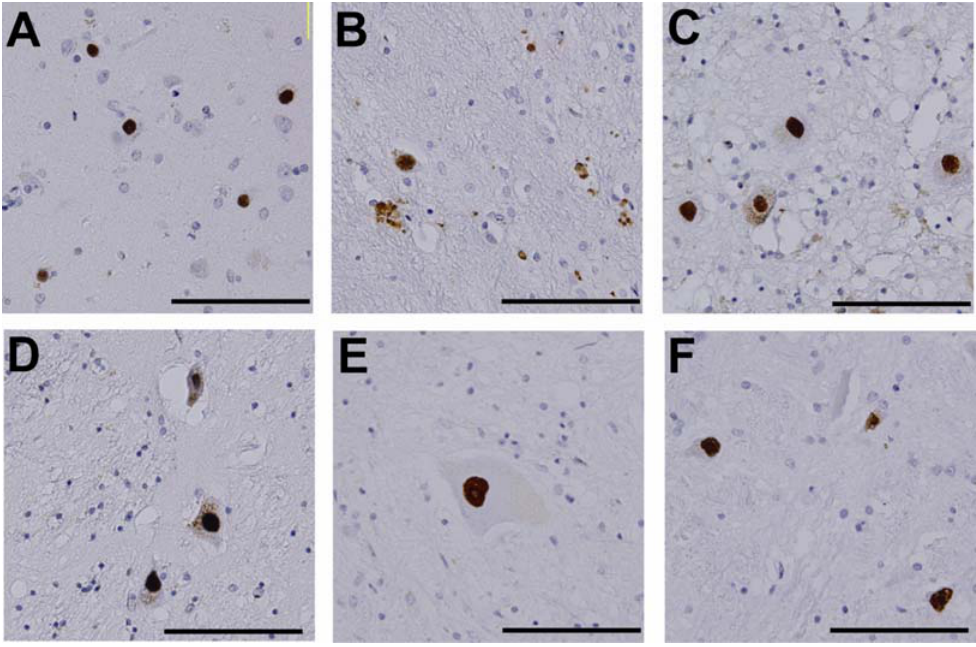
Figure 1. Accumulation of abnormal proteins in polyglutamine diseases. Immunohistochemistry of autopsy specimens from patients using an anti-polyglutamine antibody (1C2). (A) Cerebral cortex, HD; (B) Putamen, HD; (C) Dentate nucleus, DRPLA, (D) Globus pallidus, DRPLA; (E) Anterior horn of spinal cord, SBMA; (F) Pons, SBMA. Scale bar = 100 µm